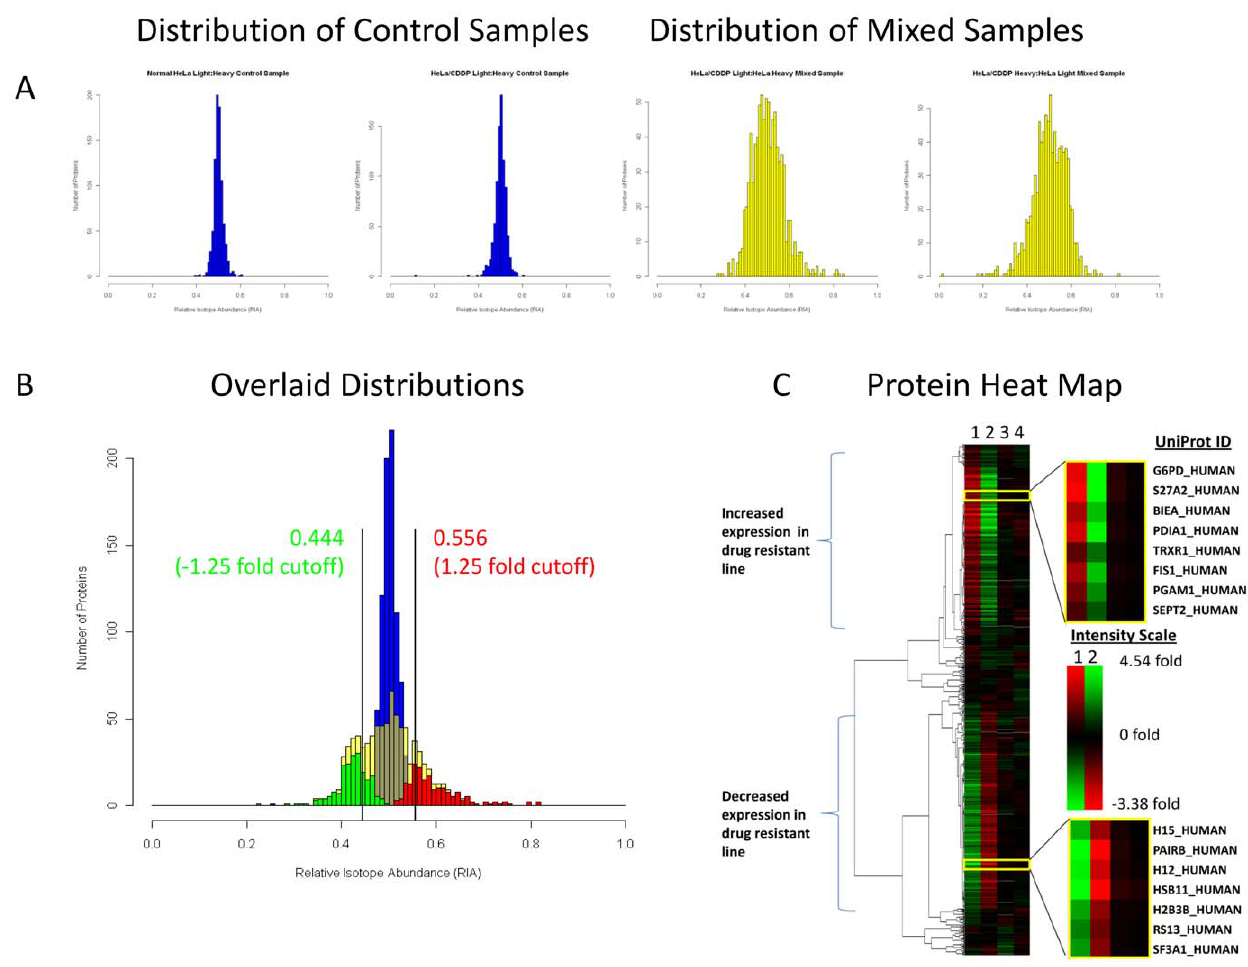
Figure 2. Distribution and heat map analysis of quantified proteins. A Histograms illustrating of the distribution of RIA’s observed for the control samples (blue) and the mixed samples (yellow). B Histogram of the distribution of averaged RIA’s with overlaid distributions of the proteins identified by ANOVA with significantly decreased ratios (green) and significantly increased ratios (red). Bars are included indicating a 6 1.25 fold change cutoff which was determined from cumulative distribution analysis of the control sample at the 99% confidence level. C Heat map generated from SILAC data comparing cisplatin resistant HeLa cells to normal HeLa cells. Lane 1 is light cisplatin resistant and heavy normal cells. Lane 2 is heavy cisplatin resistant and light normal cells. Lane 3 is a one to one mixture of light and heavy cisplatin resistant cells. Lane 4 is a one to one mixture of light and heavy normal cells. doi:10.1371/journal.pone.0019892.g002 PLoS ONE |